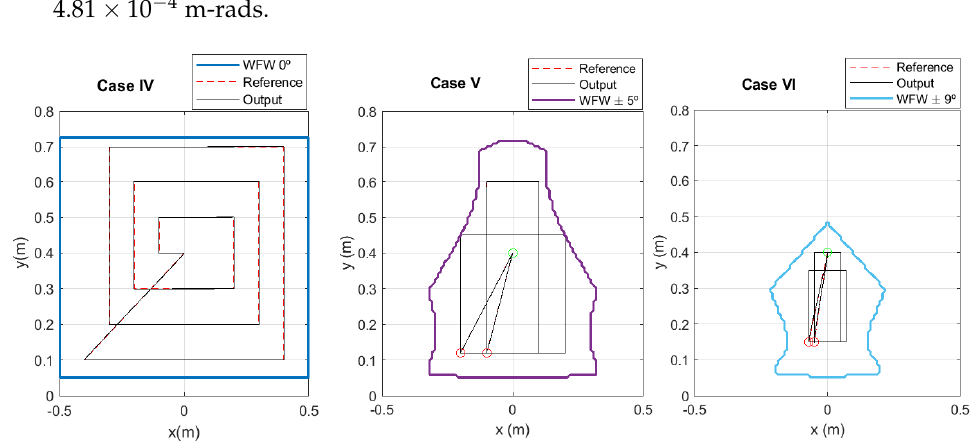
Figure 13. Results of Cases IV, V, and VI.